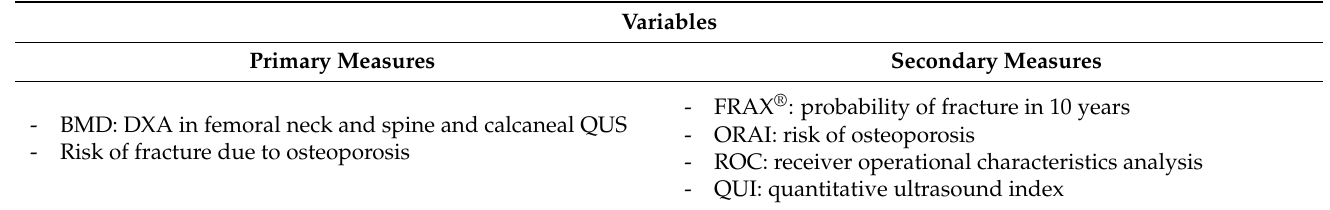
Table 1. Measures used to assess results and effects.